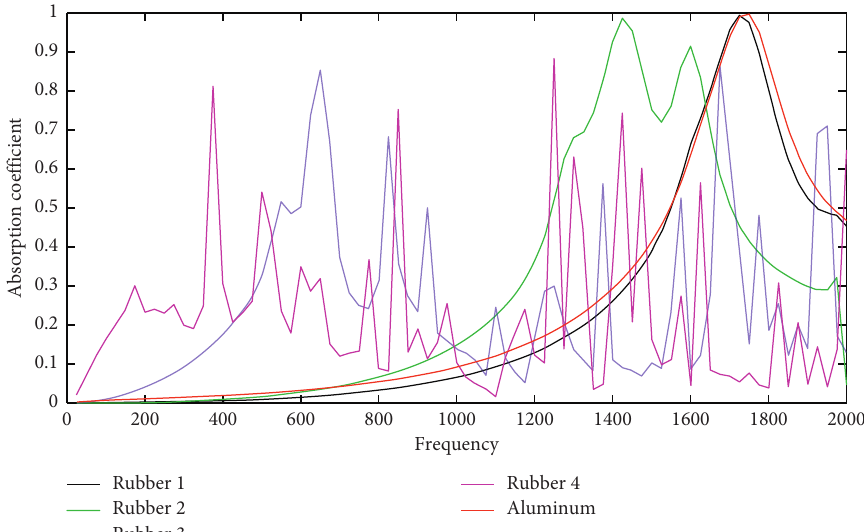
Figure 6: Absorption spectrum of Al (red), rubber 1 (black), rubber 2 (green), rubber 3 (blue), and rubber 4 (magenta). The unit of the x -axis of all the curve figures is Hz.